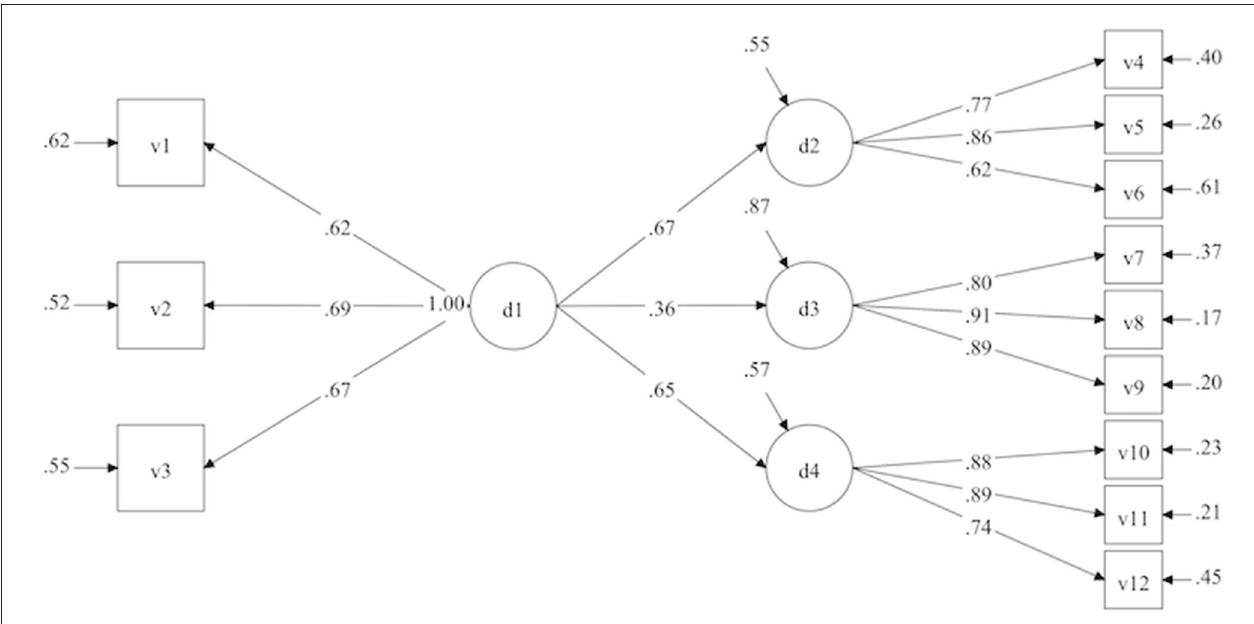
FIGURE 2 | Model of flow condition and